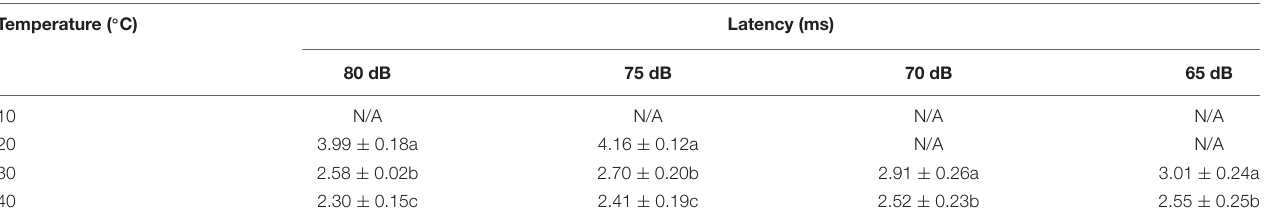
TABLE 4 | Differences in latency in Trachemys scripta elegans at each stimulus intensity among the temperature groups. Temperature ( ◦ C)